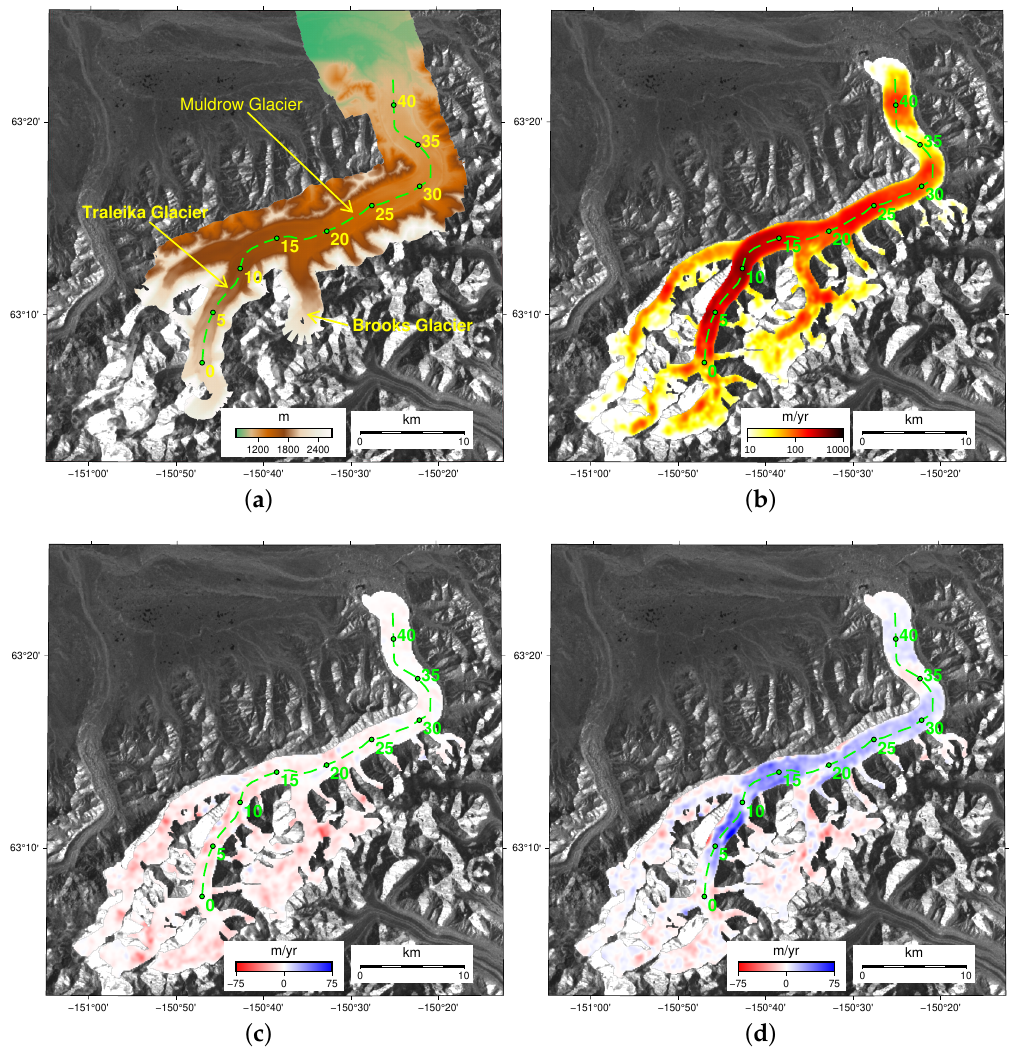
Figure 4. ( a ) SfM-derived DEM acquired on 20210919, ( b ) magnitude of flow velocity in horizontal di- rection and flow velocity in ( c ) vertical SPF and ( d ) vertical nSPF directions during 20141026–20211108. Background is intensity of Sentinel-1 image acquired on 20210907. Central flowline in green is derived from output of Open Global Glacier Model (OGGM) software [8]. Markers in green show distance along central flowline in km, for which time series are shown in Figures 7 and